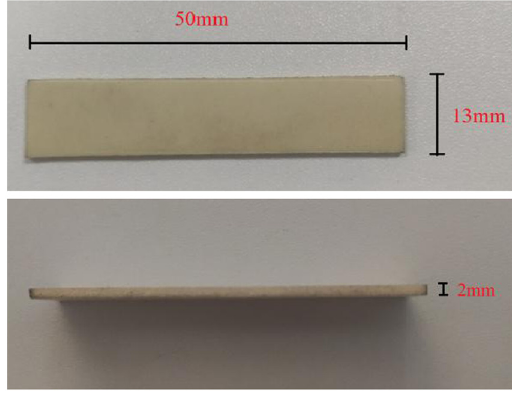
Figure 3: Polymer grouting materials sample.